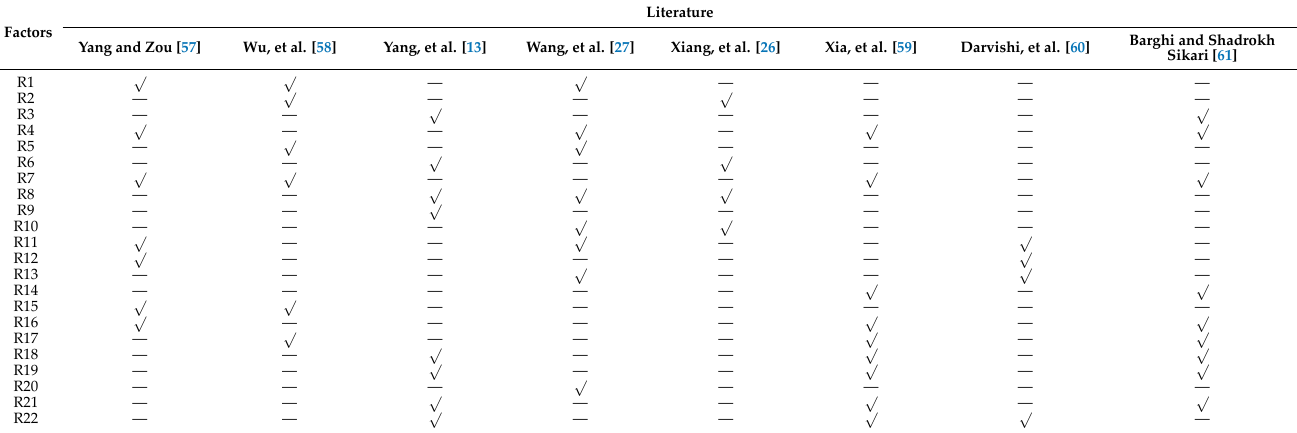
Table 3. Initially Identified Behavioral Risk